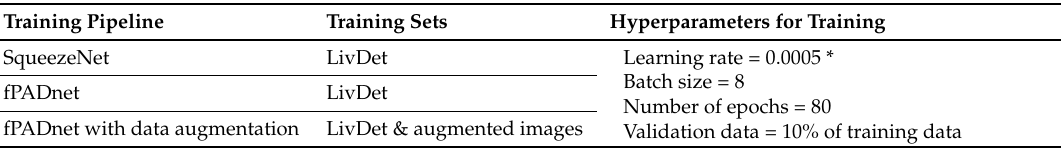
Table 4. Summary of training